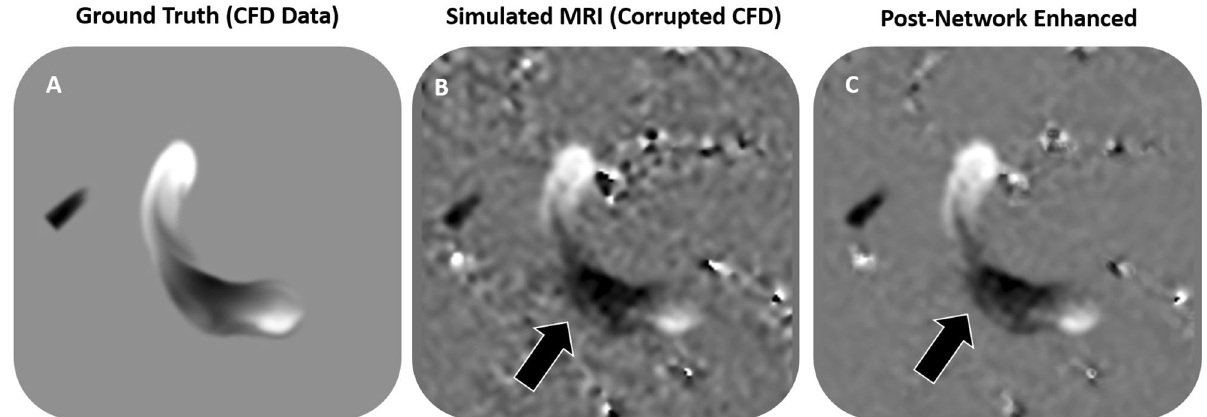
Figure 3. The trained neural network output de-noises manually corrupted data. In this example, ( a ) clean CFD data was ( b ) corrupted using a simulated MRI acquisition, and ( c ) enhanced with the trained neural network.